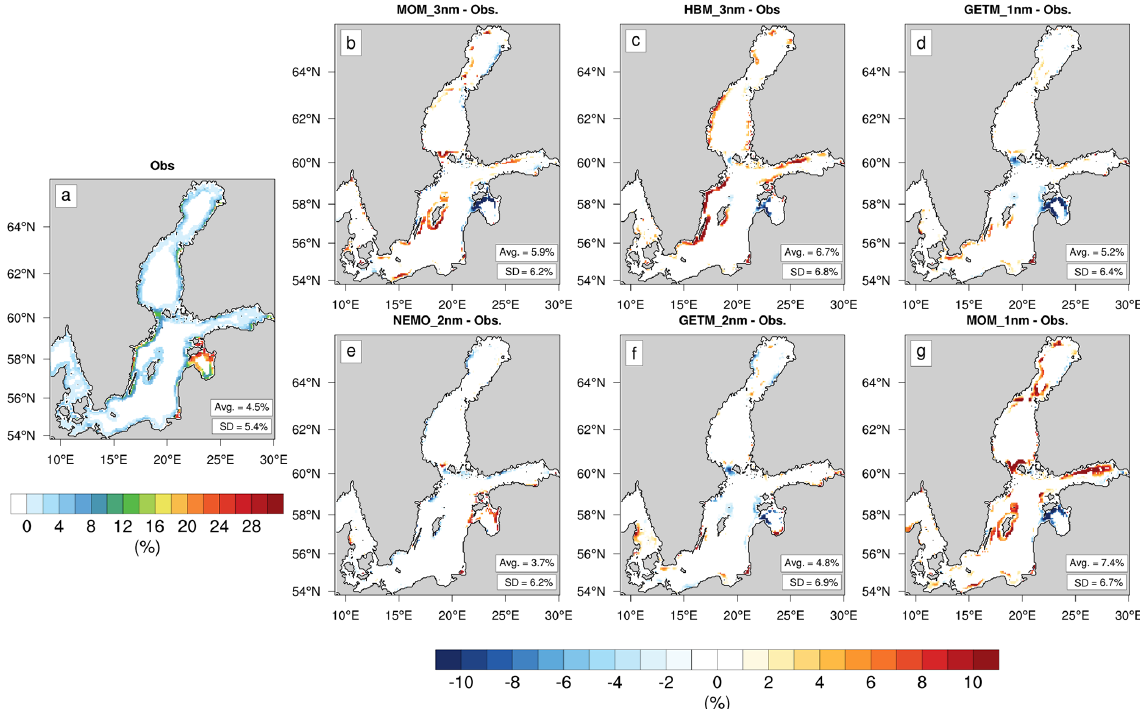
Figure 12. Annual upwelling frequencies (in %). In panel (a) , the observations are shown. In panels (b) – (e) , the errors made by models (b) MOM_3nm, (c) HBM_3nm, (d) GETM_1nm and (e) NEMO_2nm, (f) GETM_2nm, and (g) MOM_1nm are shown. The average and standard deviation are shown in the bottom-right